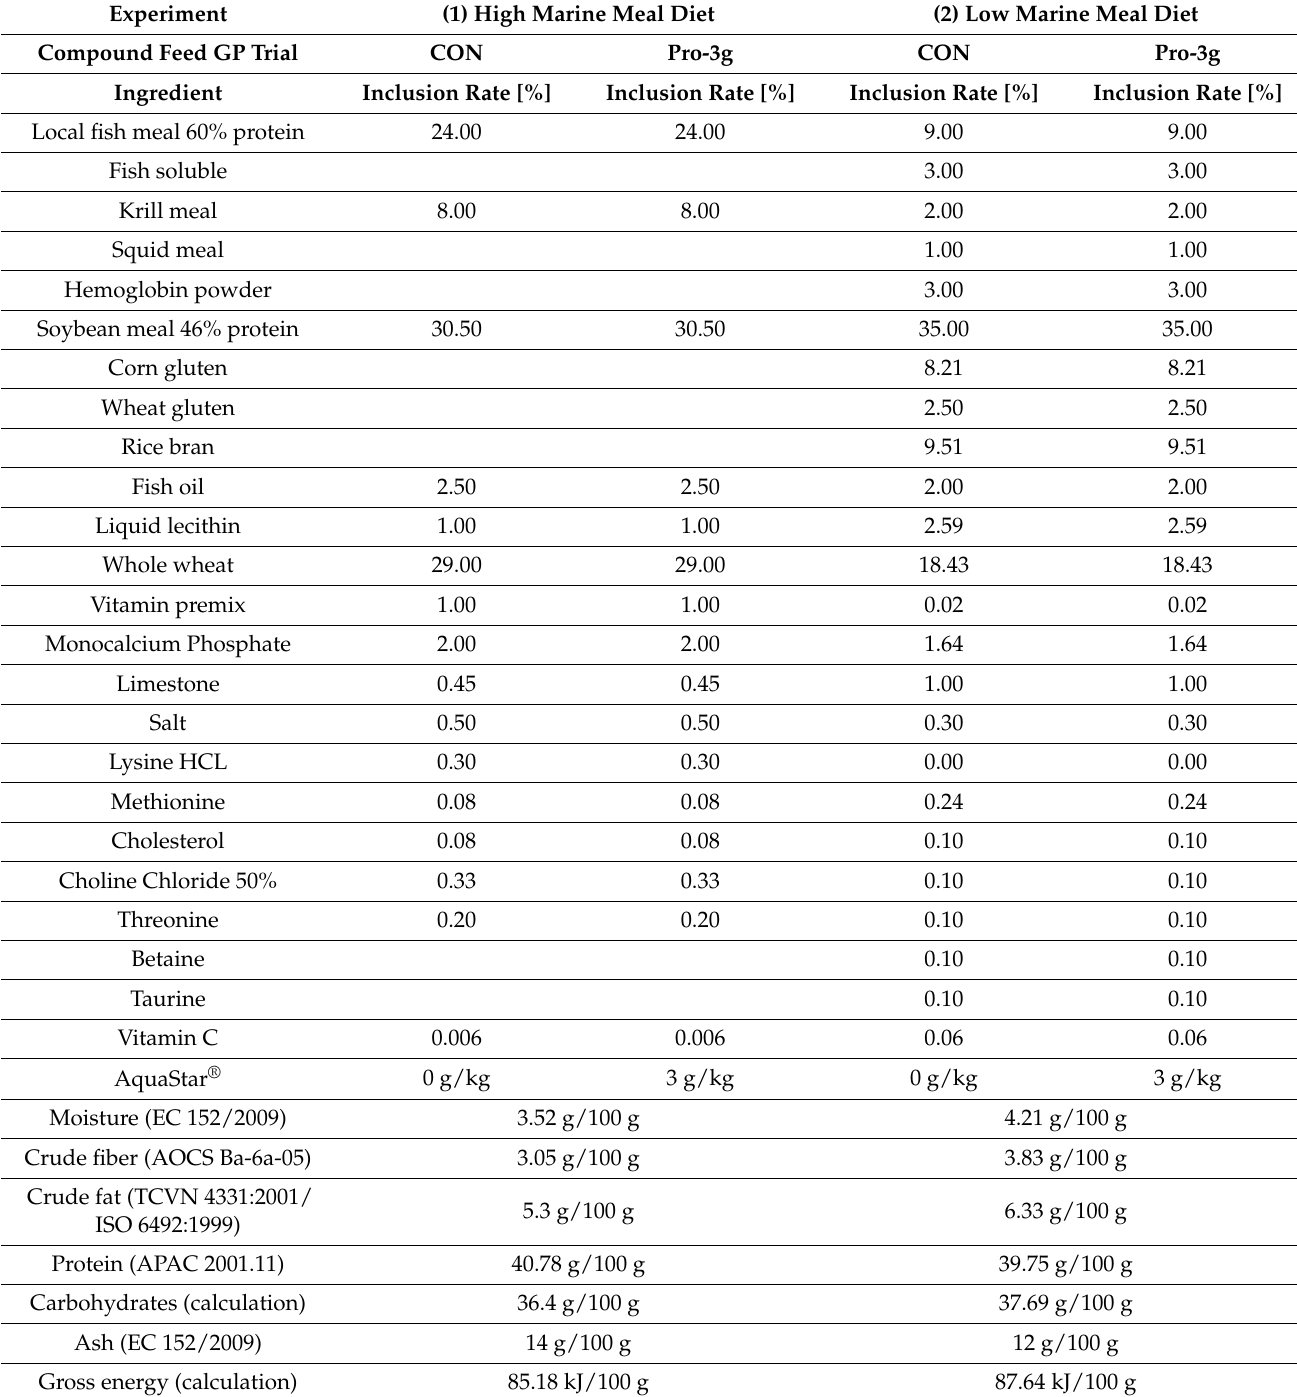
Table 1. Feed composition of the test diets.